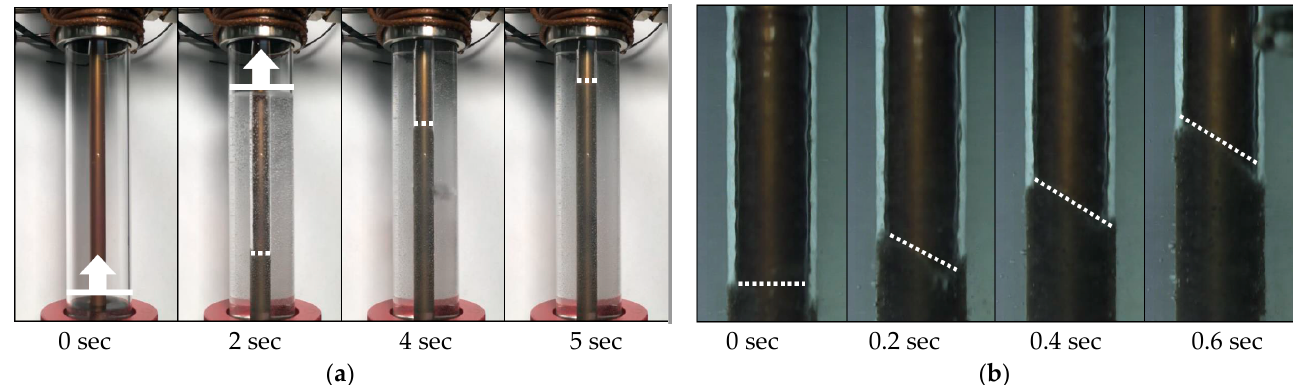
Figure 9. Pictures of the CrAl-coated Zr cladding quenching at Tw = 800 °C, T sub = 50 °C and Vc = 0.05 m/s using; ( a ) digital camera; ( b ) high-speed camera.